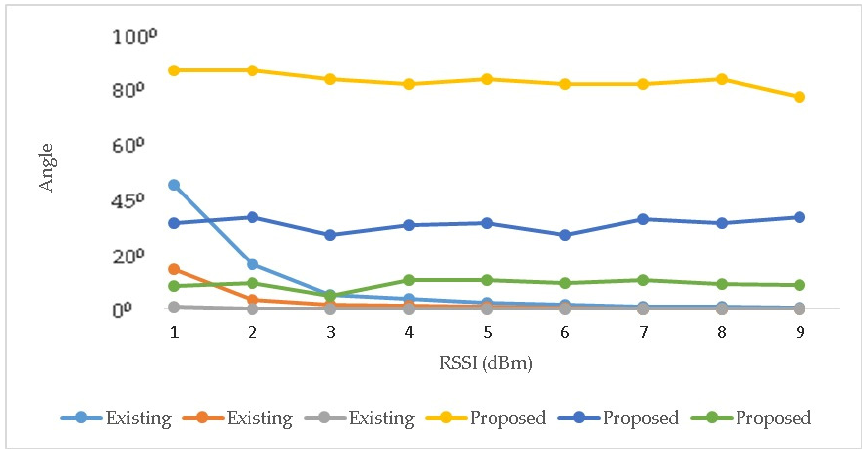
Figure 13. Patch Antenna